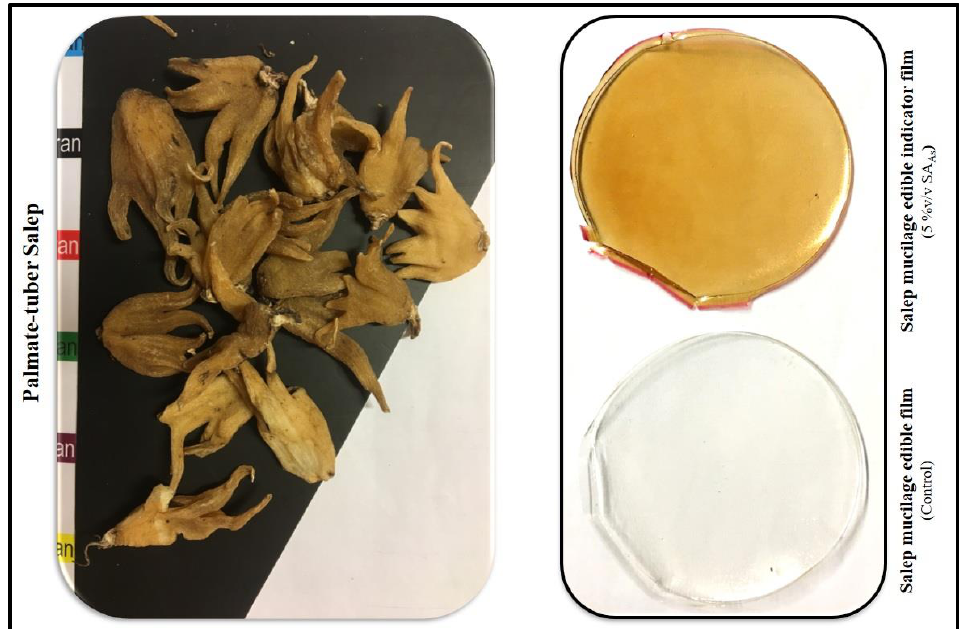
Figure 1. Photographic images of the palmate-tubers aalep and aalep mucilage control/edible indicator film.